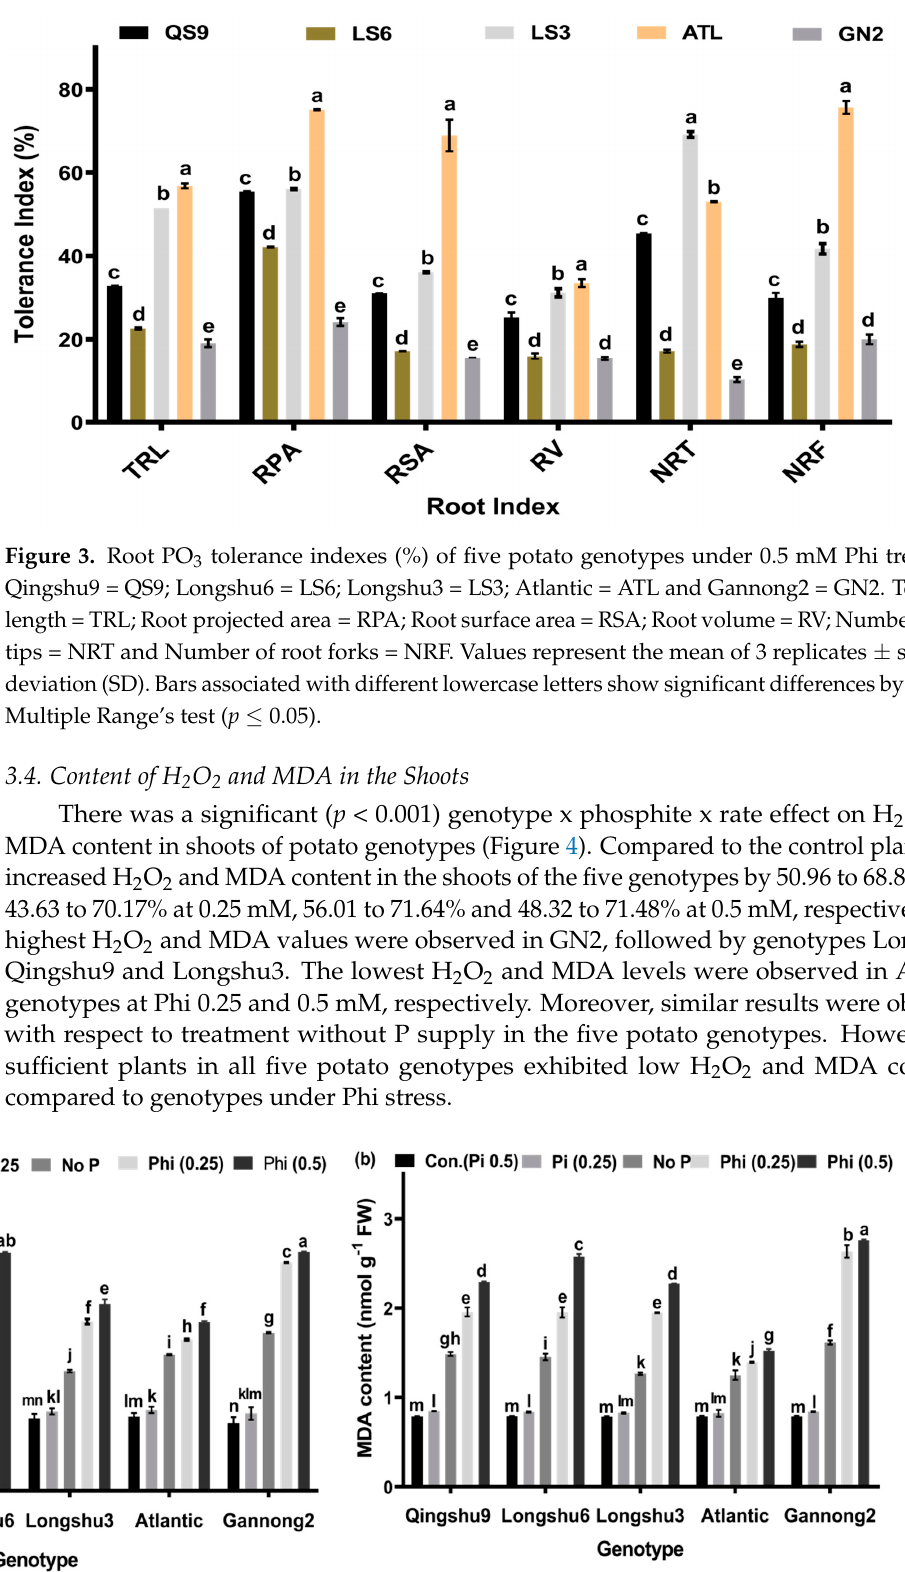
Figure 4. Effects of Phi, Pi and No-P on H 2 O 2 and MDA content; ( a ) Shows H 2 O 2 content and ( b ) shows MDA content in the shoots of potato genotypes. Values denote the mean of 3 replicates ± standard deviation (SD). Duncan multiple range test ( p ≤ 0.05) shows large differences between bars assigned to different lowercase